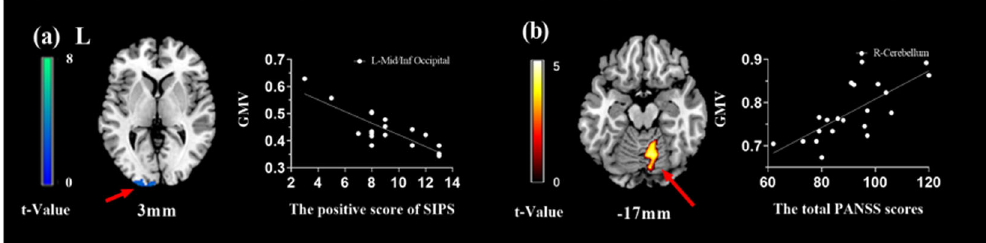
Fig. 4 Correlations between symptom severity and GMV. The correlations were thresholder at P voxel-wise < 0.005 (uncorrected), then corrected for multiple comparisons to P FWE < 0.05 by using a cluster threshold. a Correlations between GMV and the positive score of SIPS in UHR group ( T peak-level = 6.28, P FWE-corr = 0.013, k > 1052 or 3550.5 mm 3 ). b Correlations between GMV and the total PANSS scores in FES group ( T peak-level = 4.91, P FWE-corr = 0.041, k > 855 or 2,885.625 mm 3 ). Mid/Inf Occipital, Middle/Inferior occipital gyrus. Mid/Inf Temporal, Middle/ Inferior Temporal